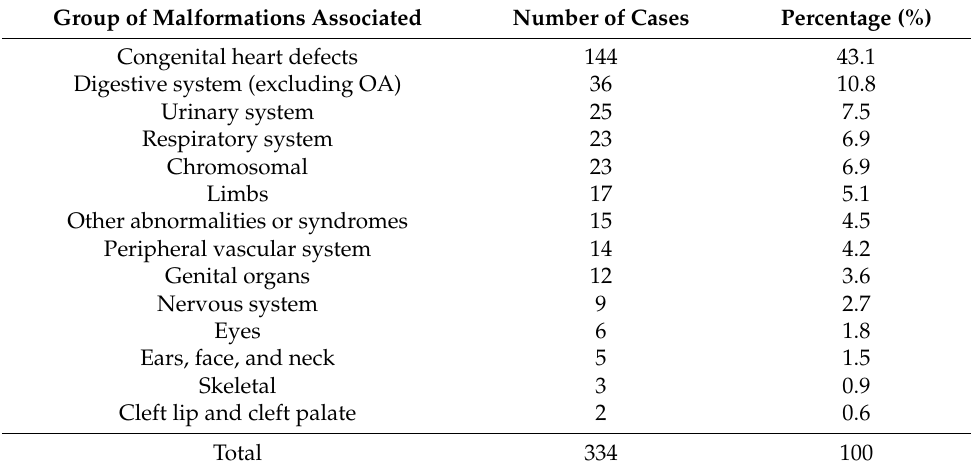
Table 4. Distribution by groups of malformations associated with oesophageal atresia during the period 2007–2019 in the Valencian